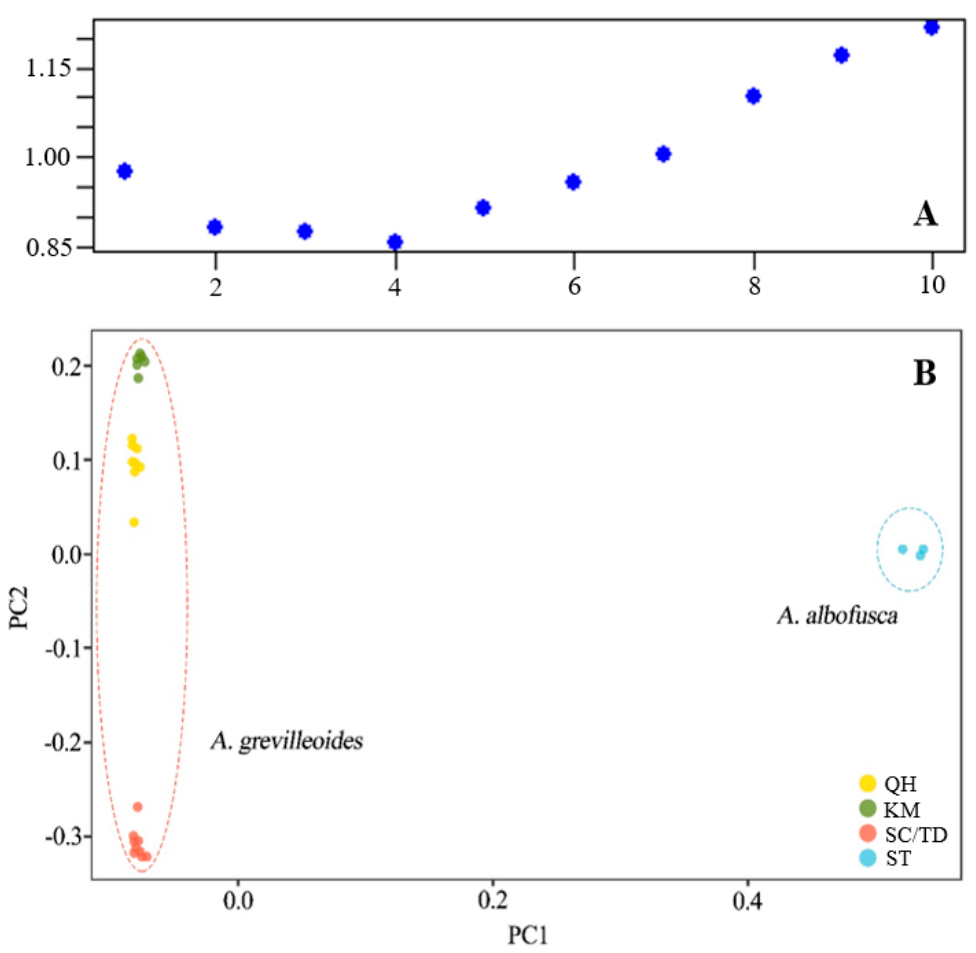
Figure 2. K value and PCA analysis of sampled populations: ( A ) The best grouping of K value; ( B ) The results of PCA analysis. ( B ) The results of PCA analysis. Table 1. Calculation of Fst between groups of A. grevilleoides and A. albofusca . QH SC TD KM SC 0.225 TD 0.188 0.031 KM 0.226 0.142 0.116 ST 0.684 0.621 0.543